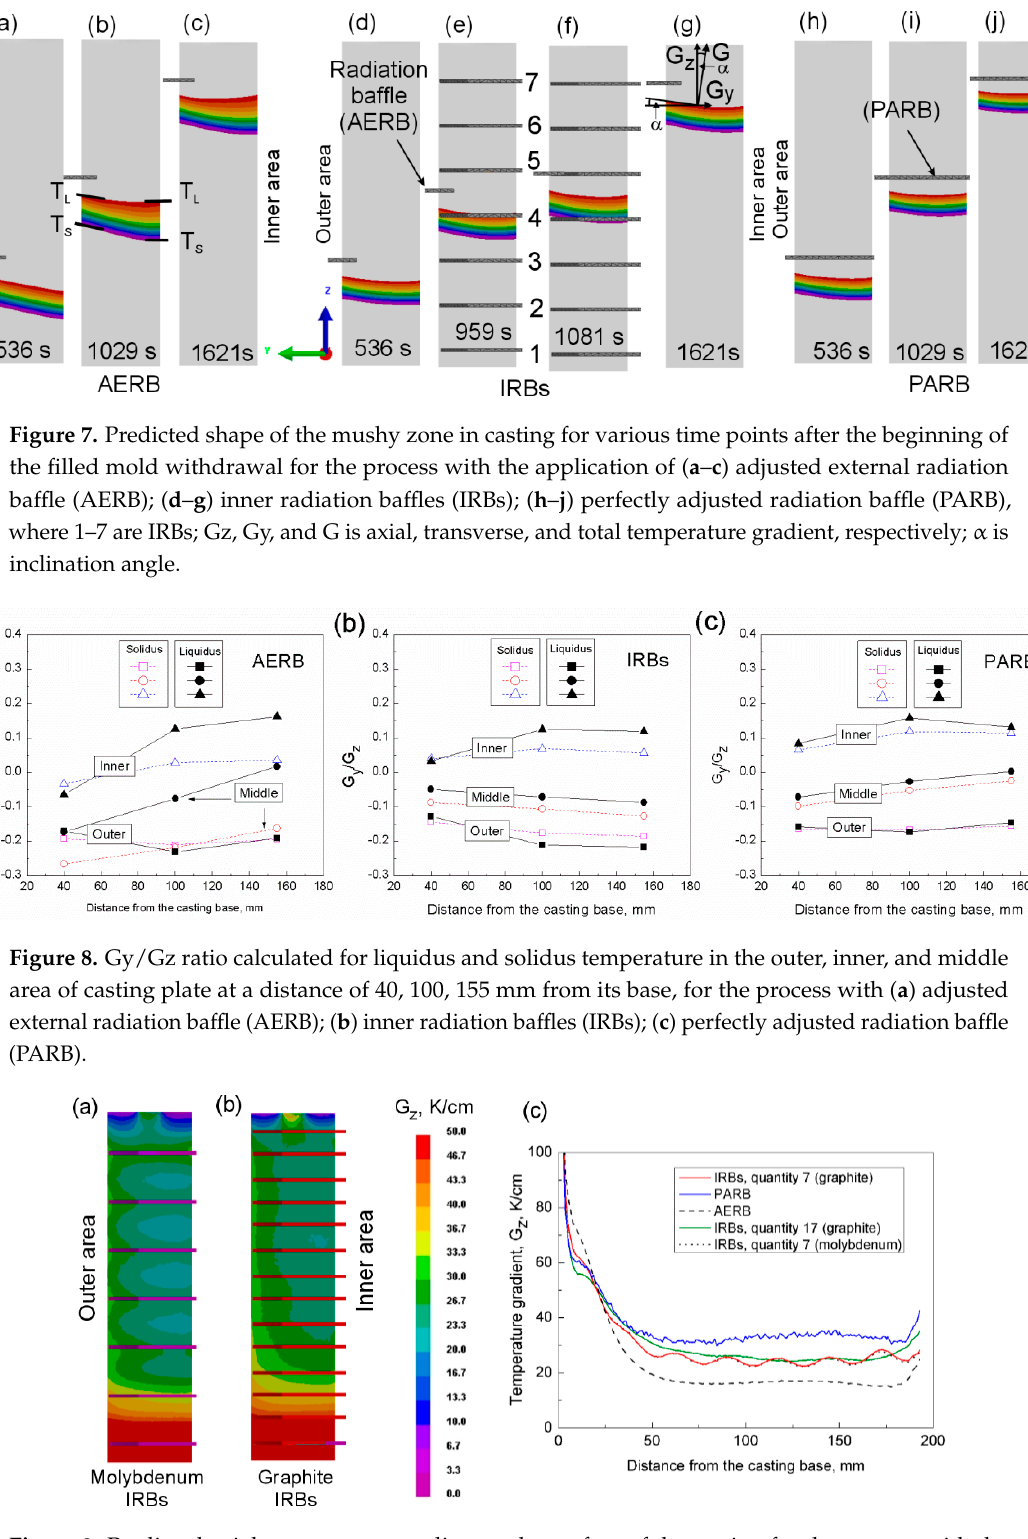
Figure 9. Predicted axial temperature gradient at the surface of the casting for the process with the application of seven ( a ) or fourteen ( b ) inner radiation baffles (IRBs) made of molybdenum ( a ) or graphite ( b ). Comparison of axial temperature gradient profiles for different manufacturing processes ( c ). AERB: adjusted external radiation baffle; PARB: perfectly adjusted radiation baffle.